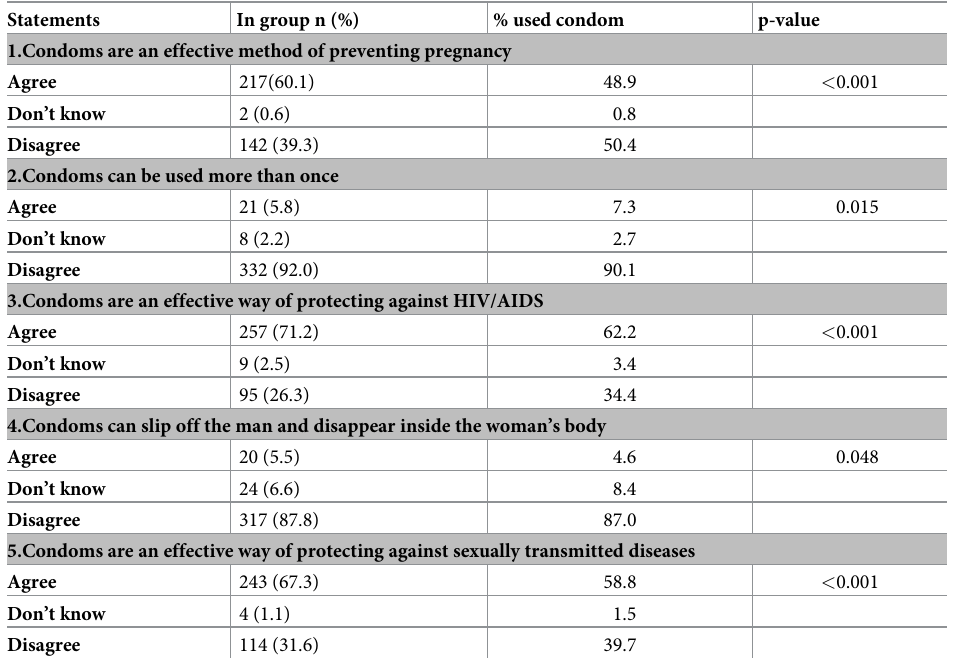
Table 2. Condom knowledge of college youth (n =